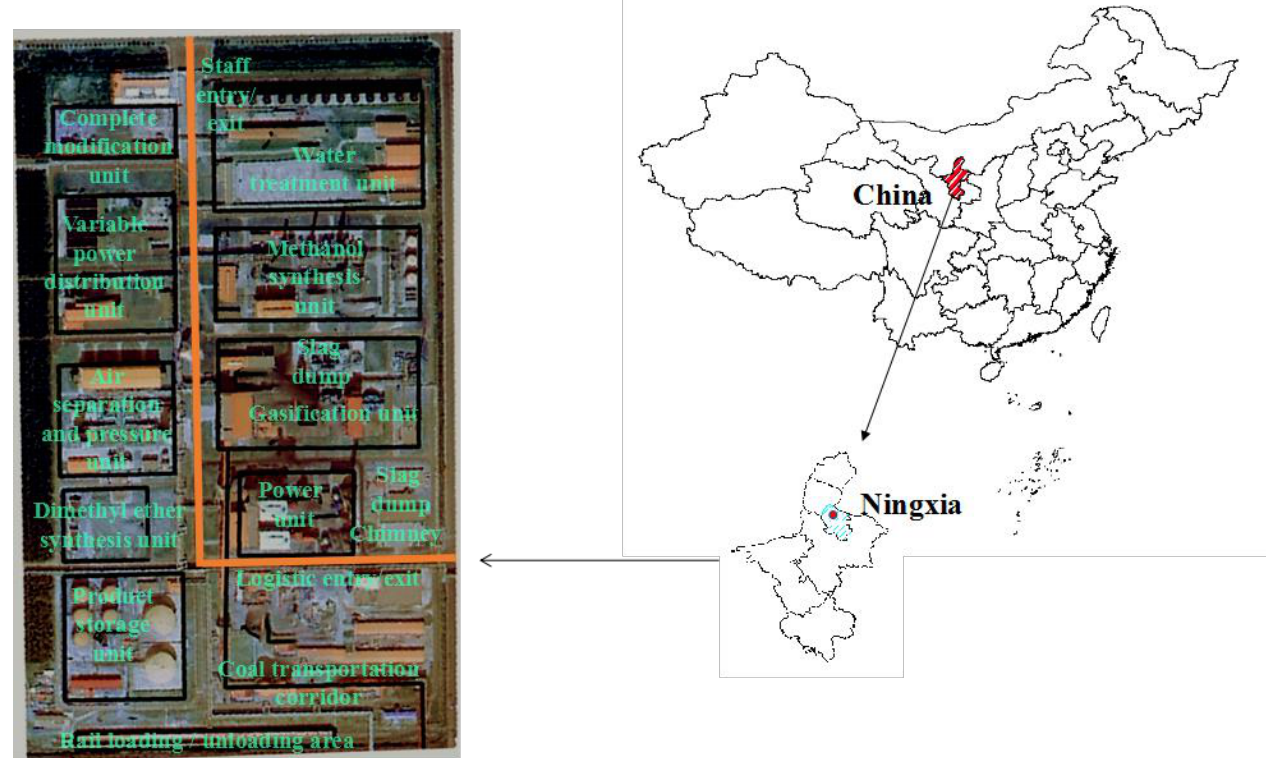
Figure 1. Location and regional distribution map of the plant.